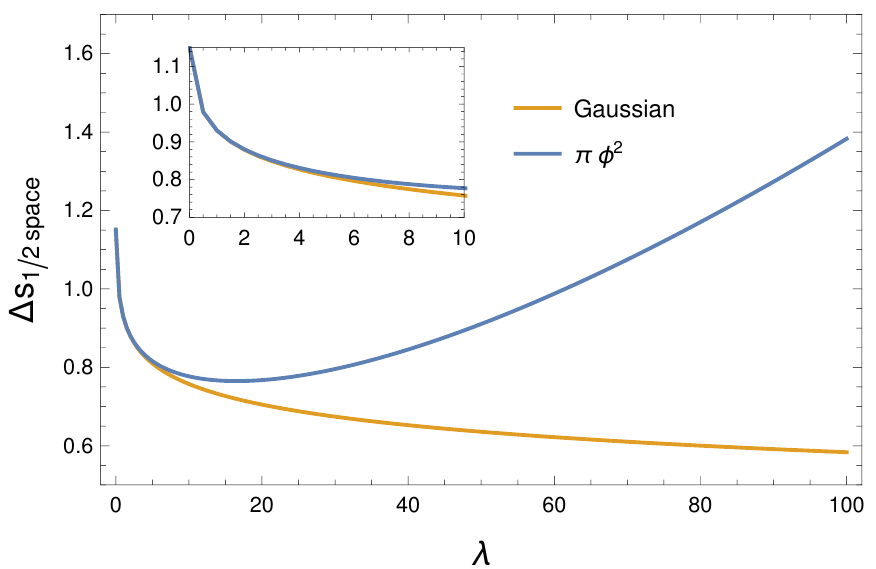
Figure 1 . Finite contributions to the half-space entanglement entropy per unit area ∆ s as a function of the coupling parameter λ for the Gaussian state Ψ[ φ ] (orange) and the non-Gaussian states ˜Ψ[ φ ] generated by the NLCT with m = 2